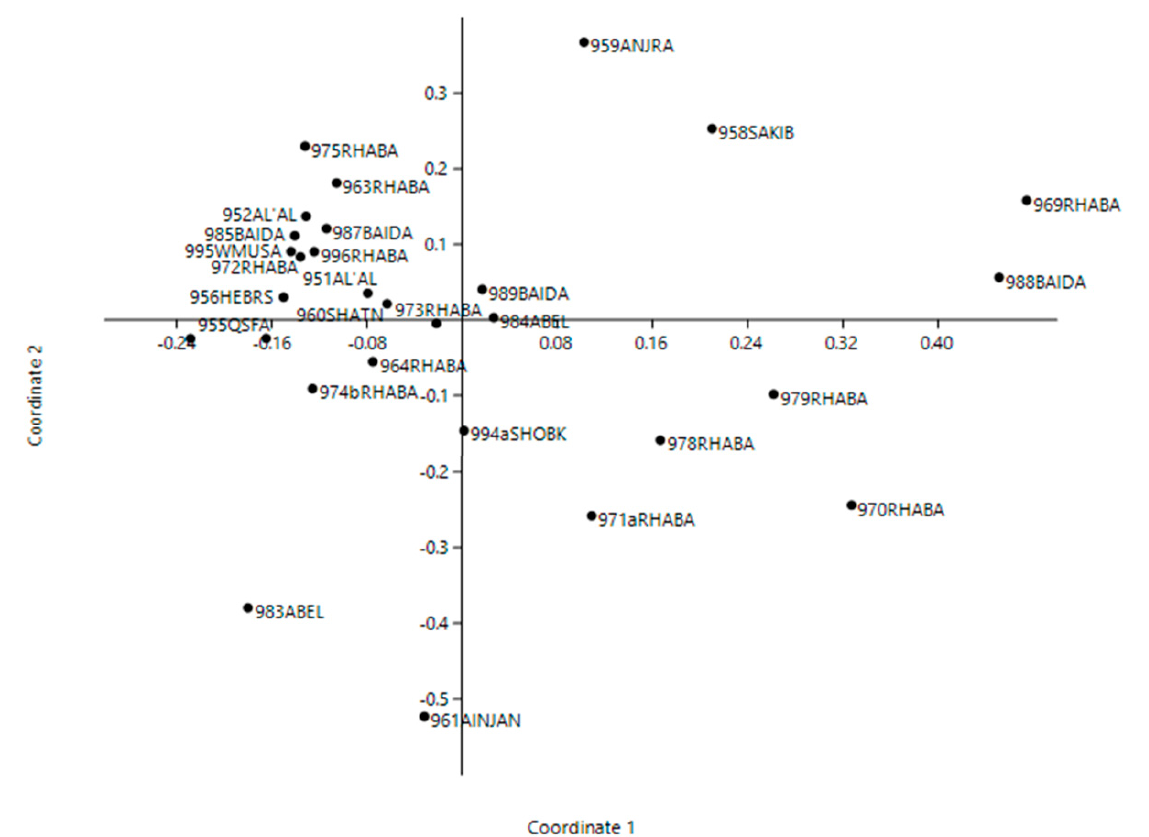
Figure 4. Principal coordinate analysis (PCoA) of 29 Jordanian tomato landraces (Accession number and collection site) based on 20 microsatellite loci. The first and second coordinate accounting for 21.1% and 16.8% variation, respectively.